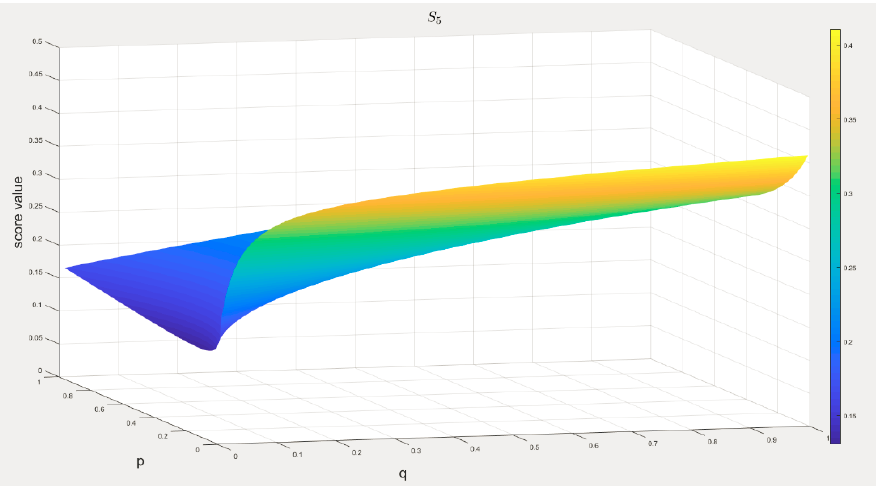
Figure 6. Values of S ∈ [ 0,1 ] 5 with p , q